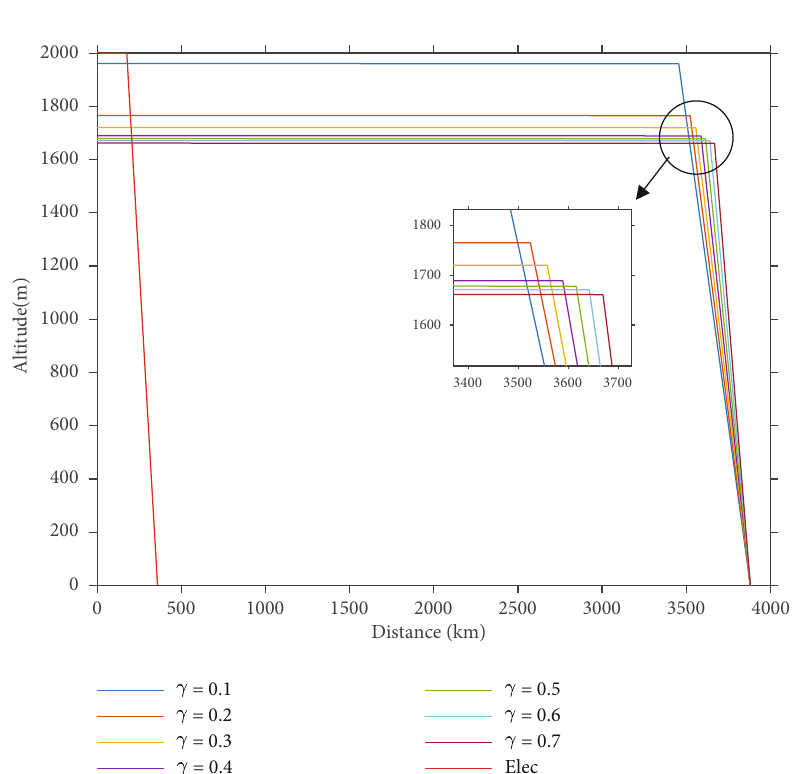
Figure 6: Acceptable region of γ .